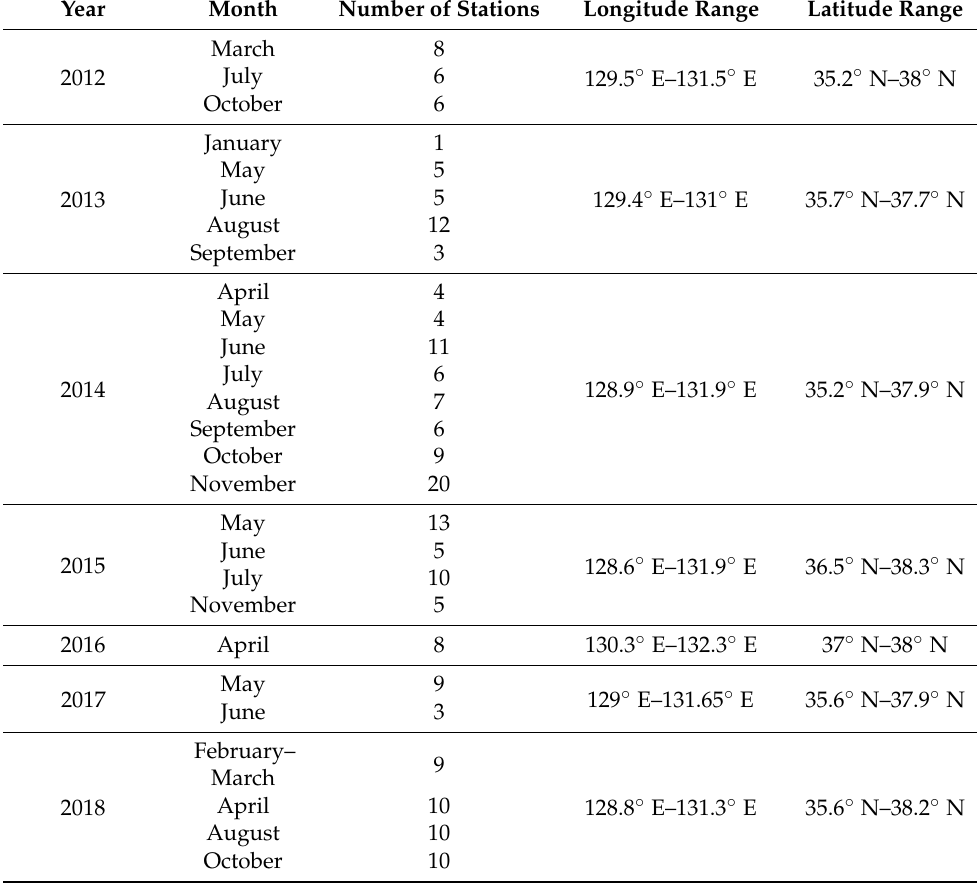
Figure 1. Field measurement stations in the East/Japan Sea (EJS) from 2012 to 2018. Dotted black lines indicate the domain for the study area. Table 1. Information for the field-measured data in the East/Japan Sea (EJS): sampling date, number of stations, and geographic